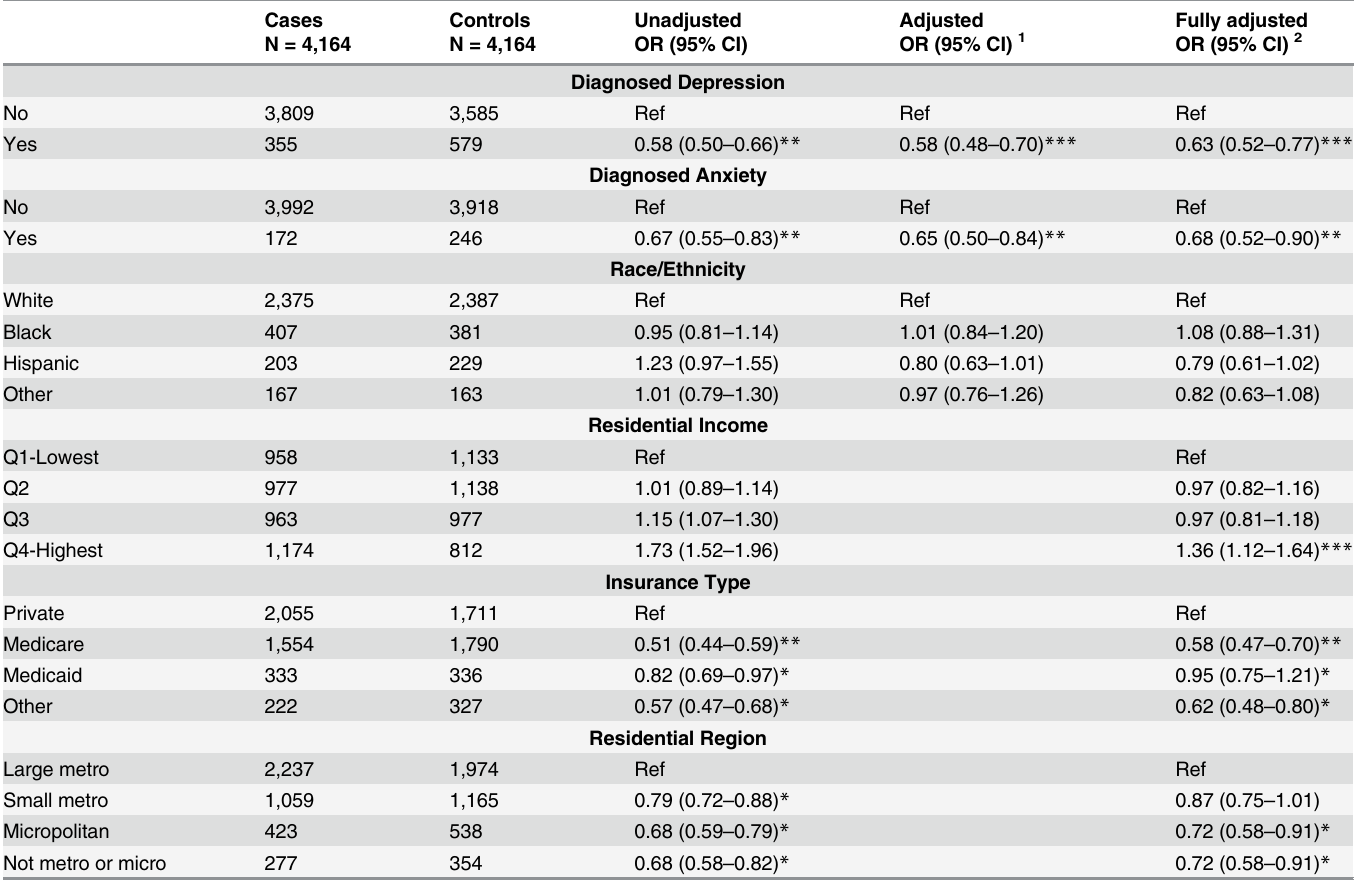
Table 2. Association between breast cancer diagnosis and clinically diagnosed anxiety and depression among matched cases and controls, Na- tionwide inpatient sample, 2006 – 2009 + .